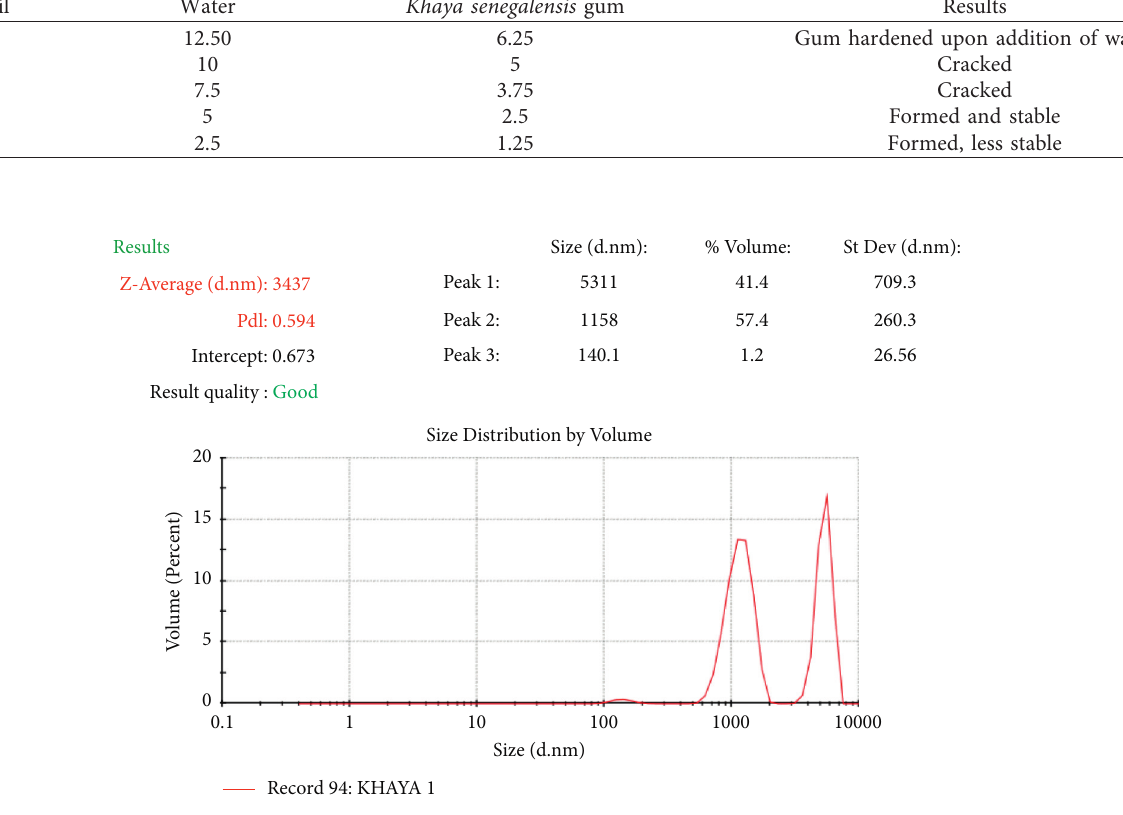
Figure 7: Droplet size and polydispersity index (PdI) of Khaya senegalensis gum